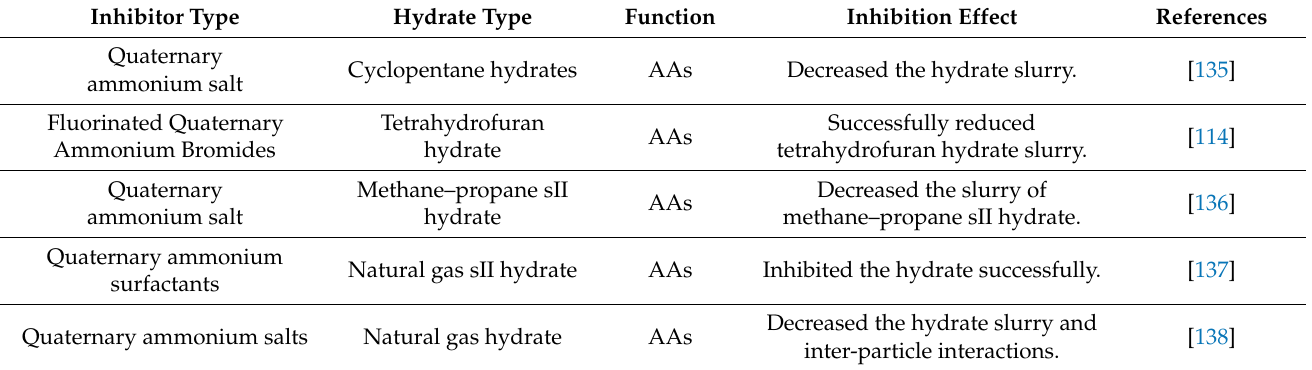
Table 6. Summary of several anti-agglomerates used as hydrate inhibitors in oil/gas industry.